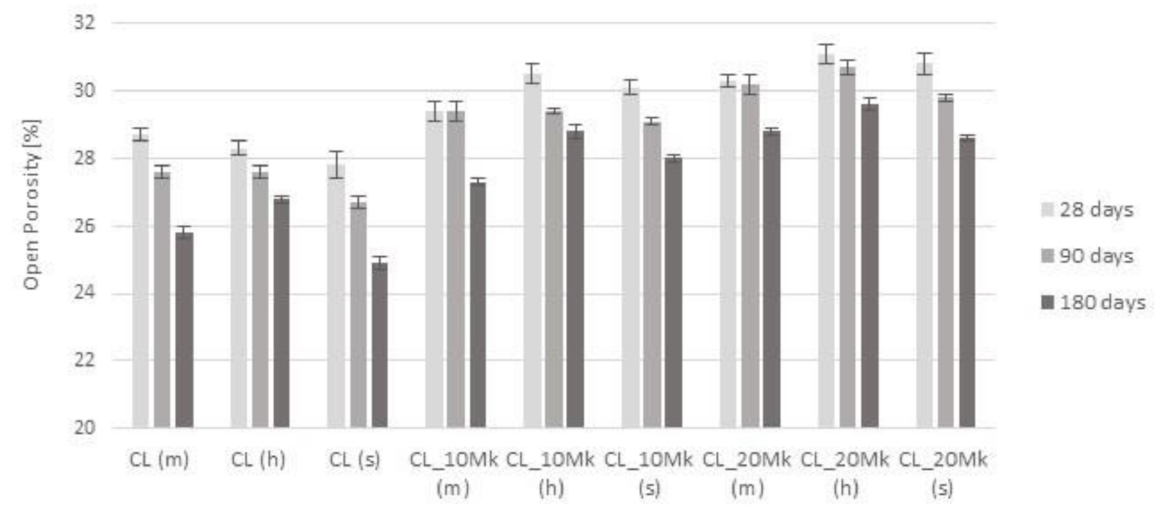
Figure 8. Open porosity of mortars with 0, 10 and 20% Mk replacing air lime, after 28, 90 and 180 days in maritime, humid and standard curing